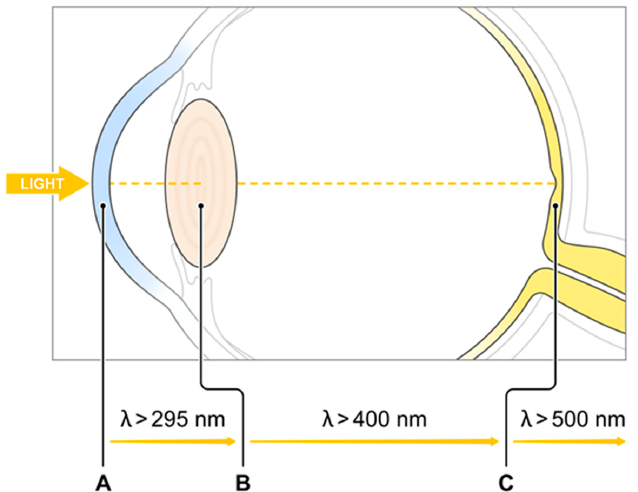
Figure 1. Schematic illustration of the attenuation of ultraviolet and blue light transmission by human ocular filters (A—cornea, B—lens, C—macular xanthophylls).